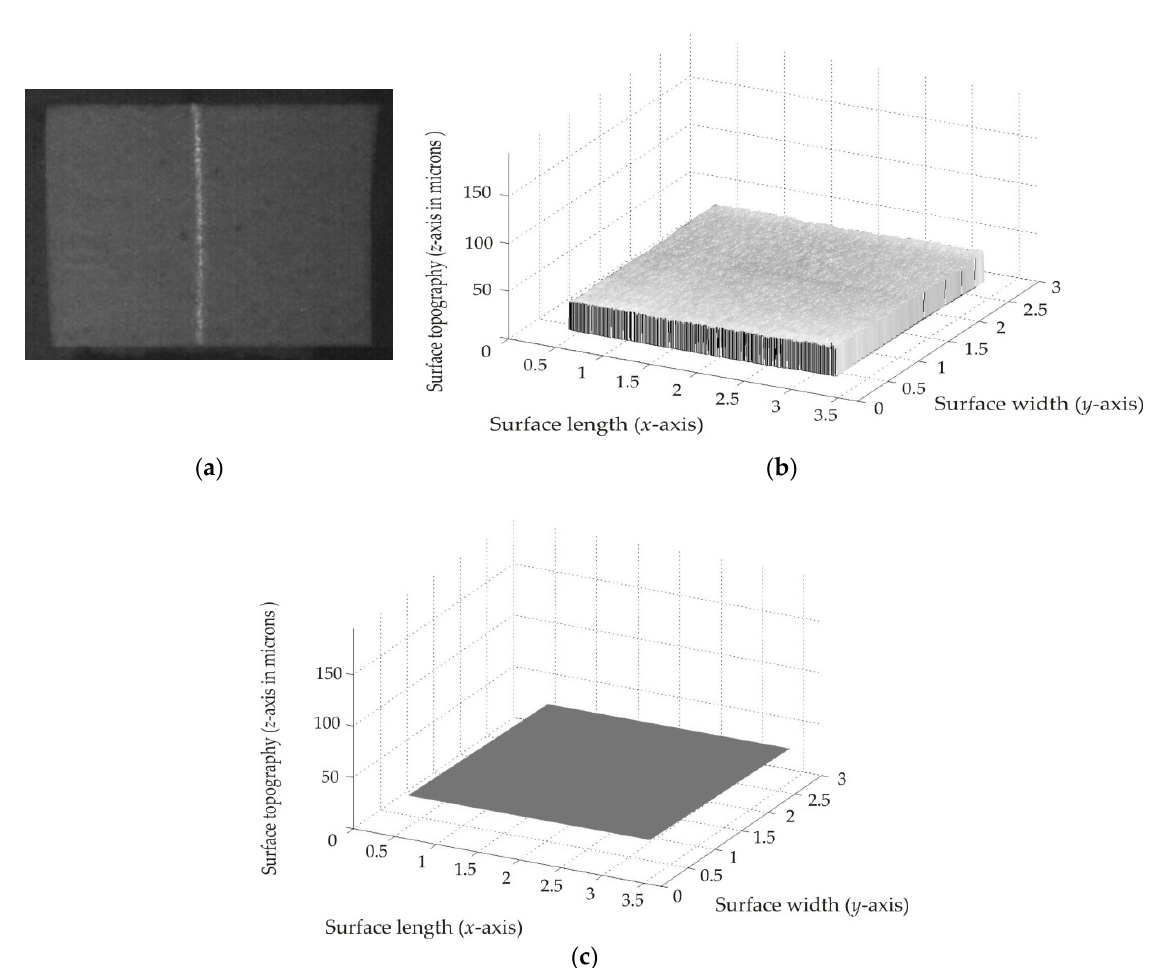
Figure 7. ( a ) Micro laser line projected on flat surface to perform micro-scale flat surface modeling. ( b ) Micro-scale surface retrieved via micro laser line scanning. ( c ) Surface computed by the flat surface model generated via Equation